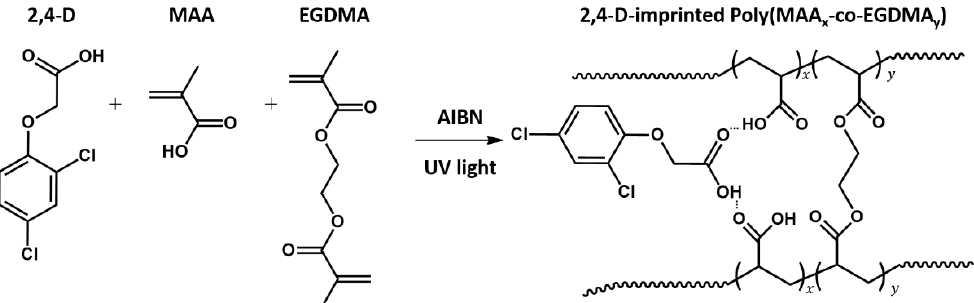
Figure 1. Molecular imprinted polymer (MIP) formation via photosynthetic reaction using a functional template, monomer, crosslinker, and initiator for 2,4-D molecular imprinting sensors.